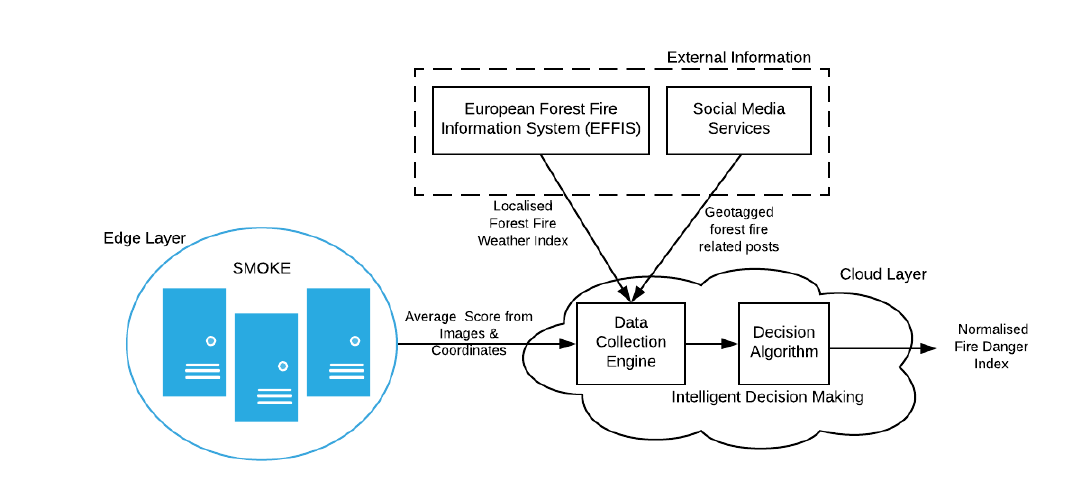
Figure 3. Intelligent Decision Making